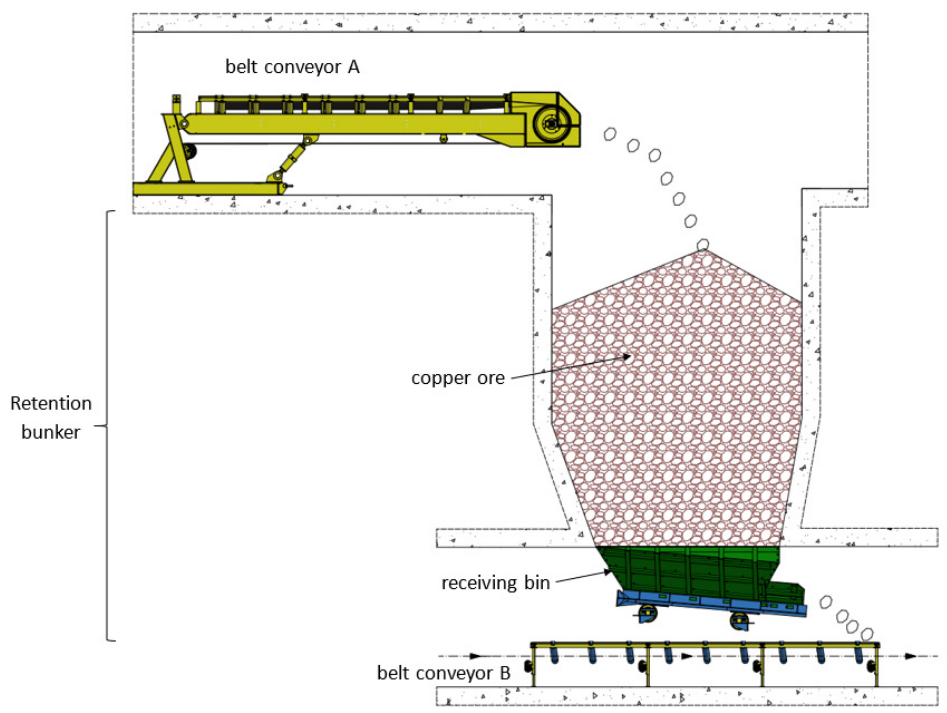
Figure 1. A representative design of a retention bunker with a receiving bin in its lower part, which enables the transfer of copper ore to the belt conveyor.